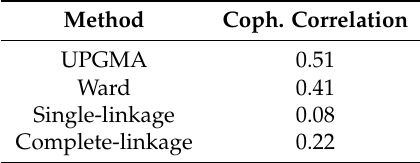
Table 2. Cophenetic (coph.) correlations. Unweighted pair-group method with arithmetic means (UPGMA).